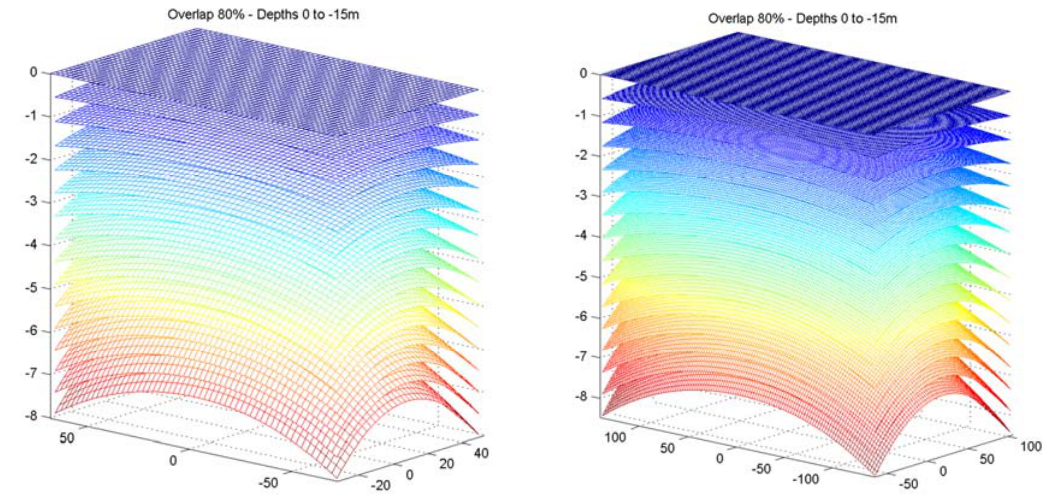
Figure 5. Difference of apparent and correct depth, for depths 0–15 m, at 1 m step, if acquired with a SwingletCAM from 100 m ( left ) and 200 m ( right ), flying height, with 80% overlap.